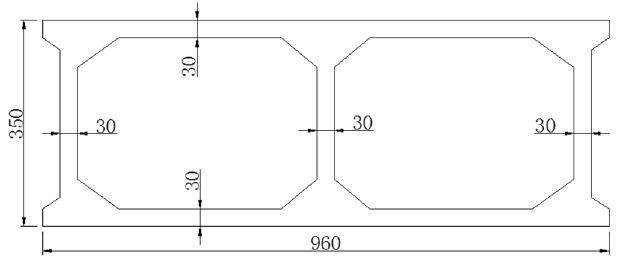
Figure 5. Arch rib standard section (unit: cm).